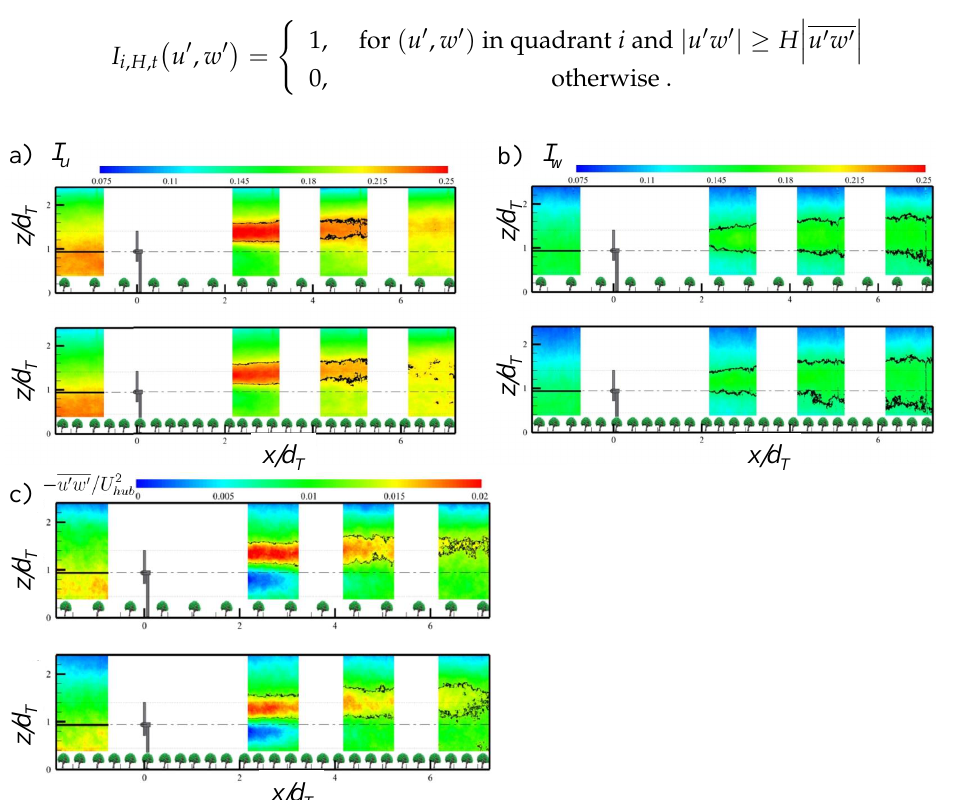
Figure 7. Turbulence intensity of the ( a ) streamwise, I u = σ u / U hub , and ( b ) vertical, I w = σ w / U hub , velocity components; ( c ) kinematic shear stress, − u (cid:48) w (cid:48) / U 2 . The top subfigure in each case denotes hub the intermediate forest and the bottom subfigure the dense forest case, as indicated by the tree drawing. Iso-contours denote the values to those of the incoming flow at the hub